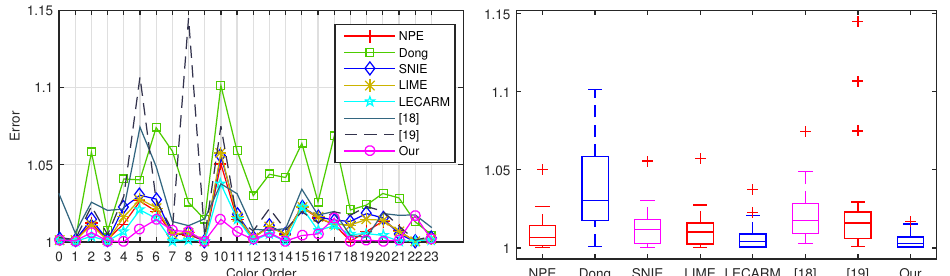
Figure 5. The left box-plot shows the errors of 24 colors from eight algorithms, each error is displayed on the right side in order from left to right, top to